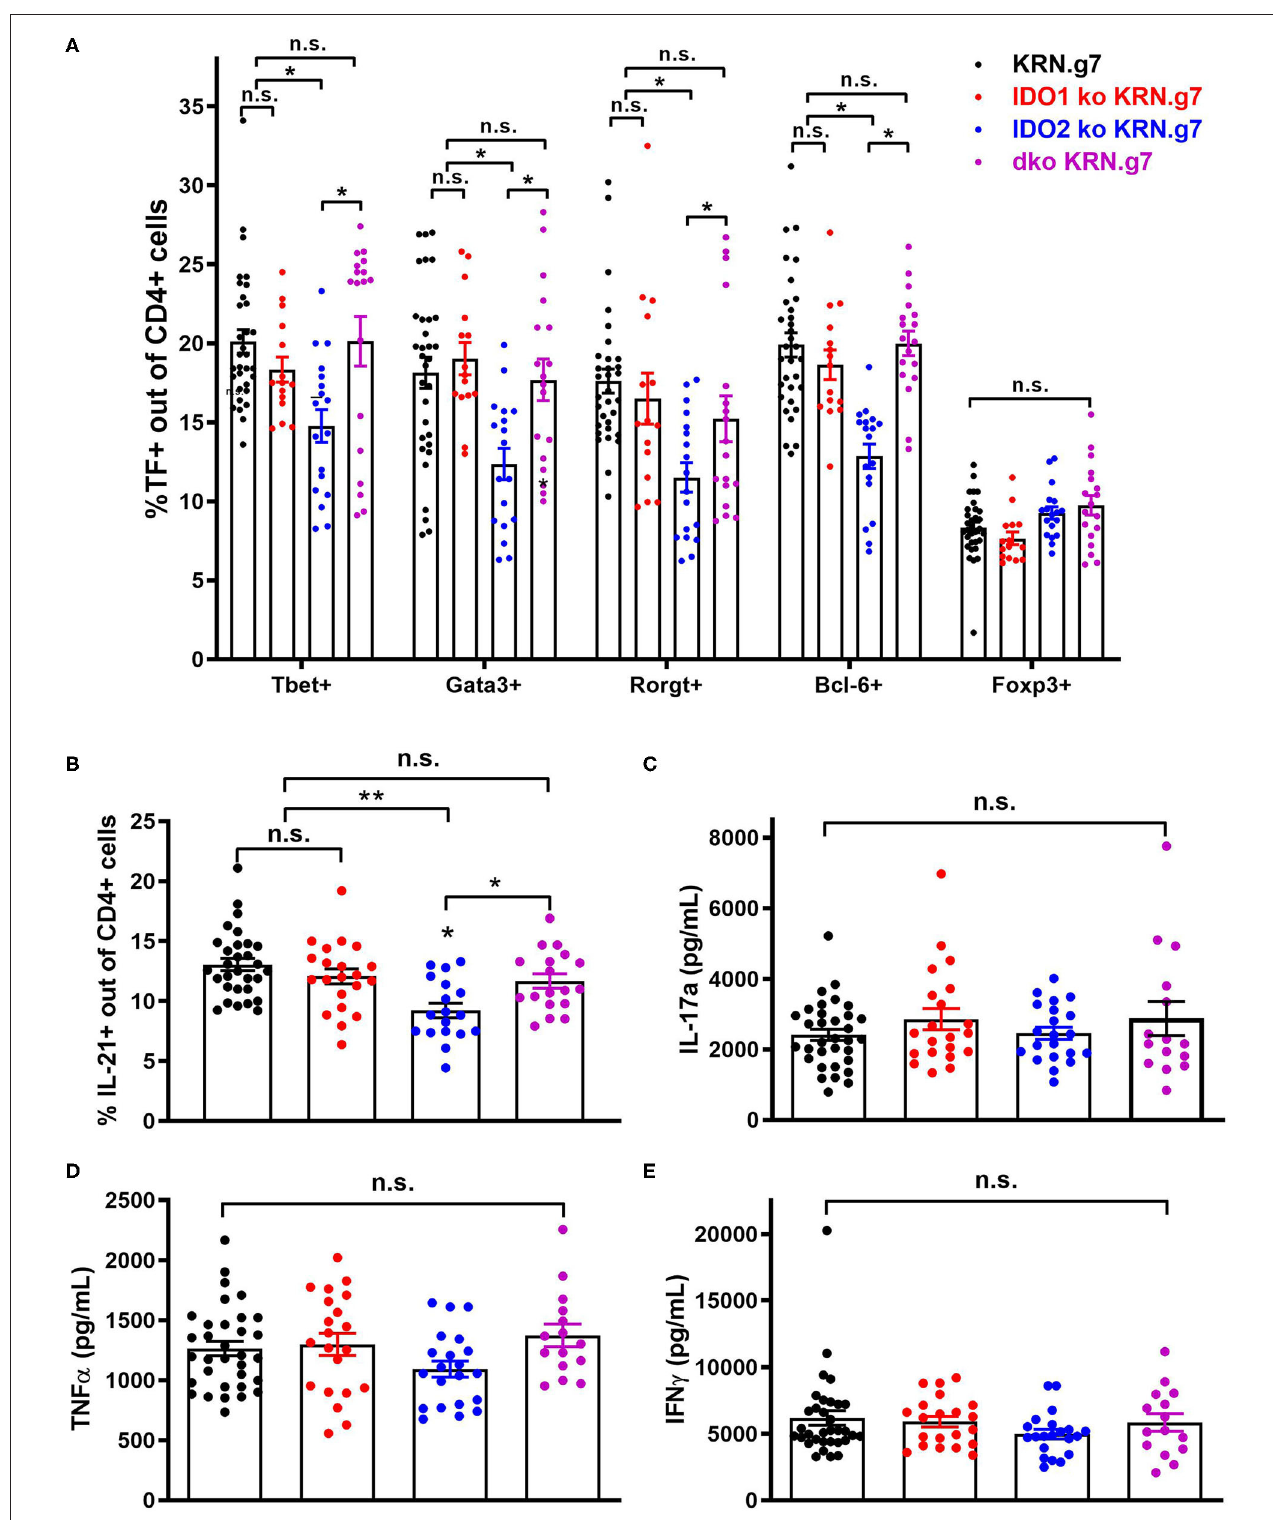
FIGURE 3 | Decreased autoreactive T cell activation in IDO2 ko mice is mediated by IDO1. (A) Frequency of CD4 + T helper cell subpopulations were measured by flow cytometry by intracellular staining for the transcription factors T-bet (Th1), GATA-3 (Th2), ROR γ t (Th17), Bcl-6 (Tfh), and FoxP3 (Treg). Symbols represent individual mice and histograms show mean % ± SEM of each subpopulation out of total CD4 + T cells. (B) Cells from the joint dLNs were cultured for 4h in PMA +